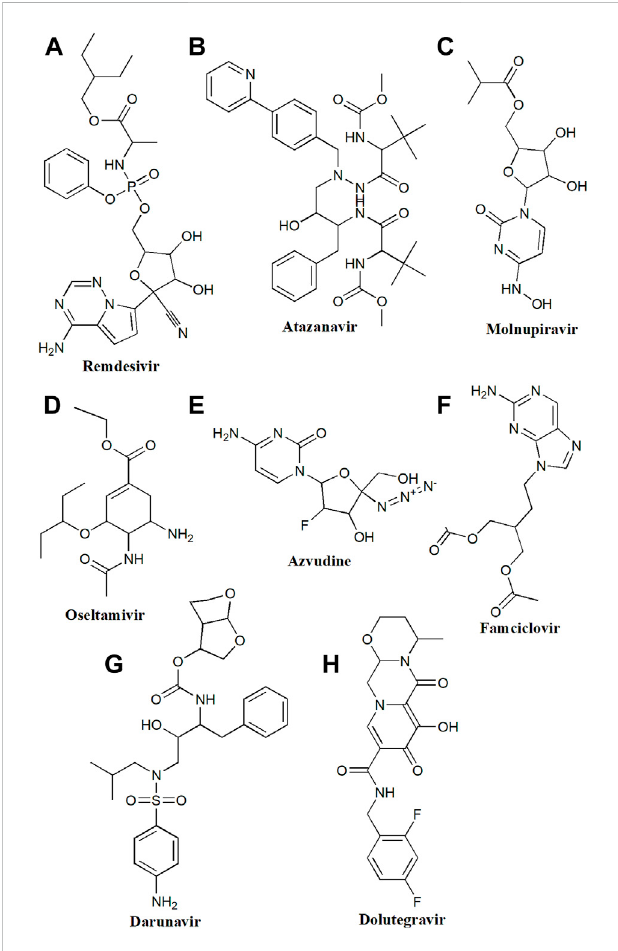
Chemical structure of (A) Remdesivir, (B) Atazanavir, (C) Molnupiravir, (D) Oseltamivir, (E) Azvudine, (F) Famciclovir, (G) Darunavir, (H)